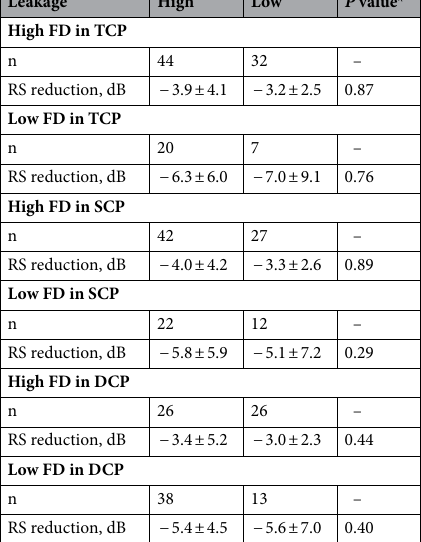
Table 4. Comparison of retinal sensitivity at each flow density between the high and low leakage groups with high retinal thickness (> 261 μm). *Wilcoxon rank-sum test. DCP deep capillary plexus layer, FD flow density,